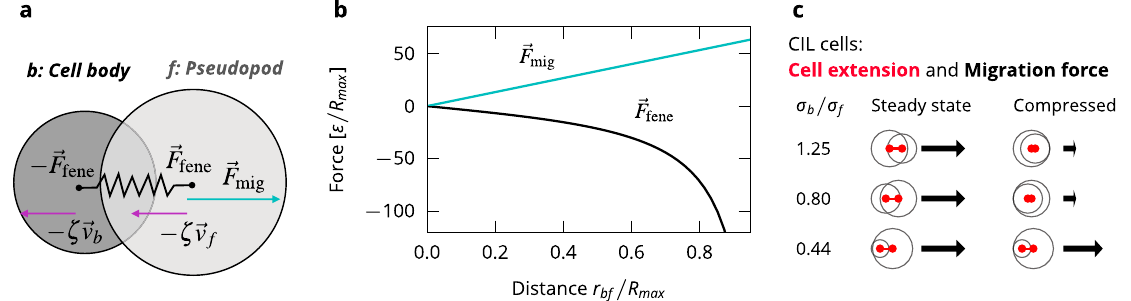
Figure 1. Illustration of the cell model. ( a ) Schematic of a cell with a finite extensible non-linear elastic spring → → connecting the disks and exerting the force F fene (Eq. 1), the migration force F mig acting on the front disk (Eq. 2), → → and the friction forces - ζ v b and - ζ v f . ( b ) Forces acting on the two disks composing a cell separated by a distance → = r r bf bf (Eq. 1, 2). ( c ) Cell extension r bf (red line segment) and migration force (black arrow) for the CIL cells in the steady state and a compressed state in which the disks are fully